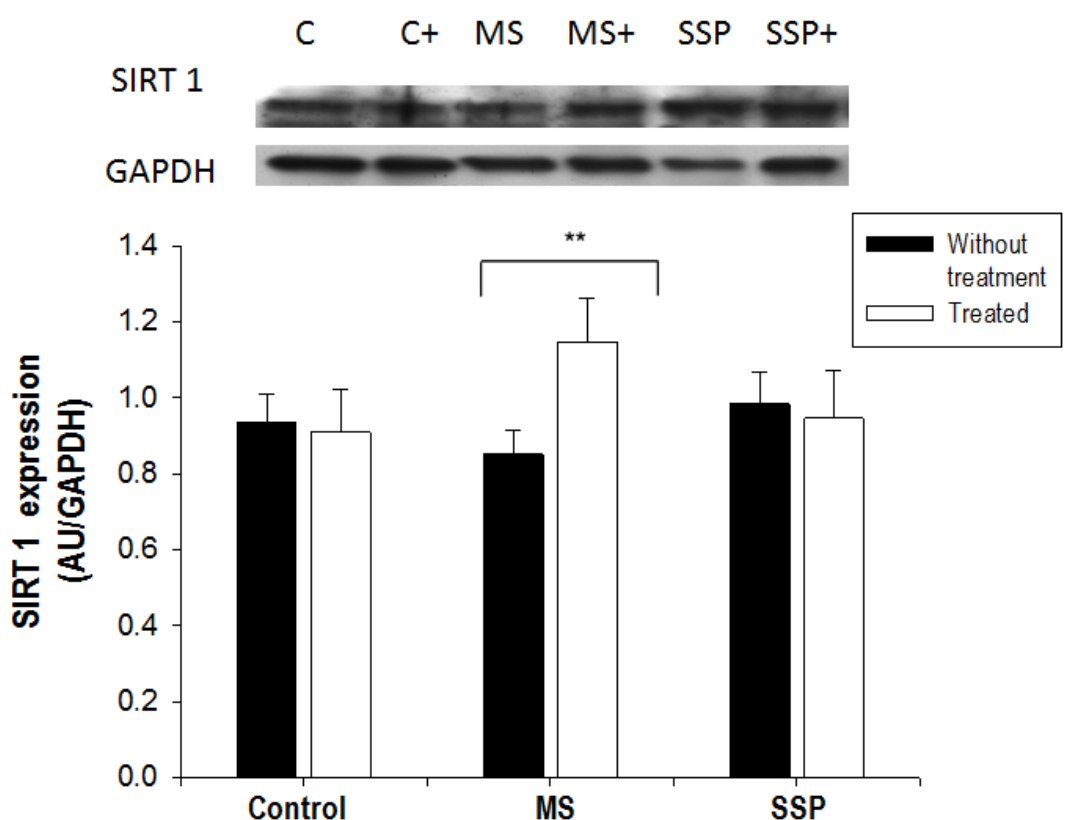
Figure 4. E ff ect of the treatment for 1 month (from 6 to 7 months of age) with RSV / QSC on the Sirtuin 1 (SIRT 1) expression in rats exposed to sucrose for a short- (SP) and long- (MS) term period. A representative Western blot image is shown. Data represent the mean ± SEM of five di ff erent rats from each group ** p < 0.05. Abbreviations: C = control; C + = control treated with polyphenols; MS = metabolic syndrome; MS + = metabolic syndrome treated with polyphenols; SSP = short sucrose period; SSP + = short sucrose period treated with polyphenols.